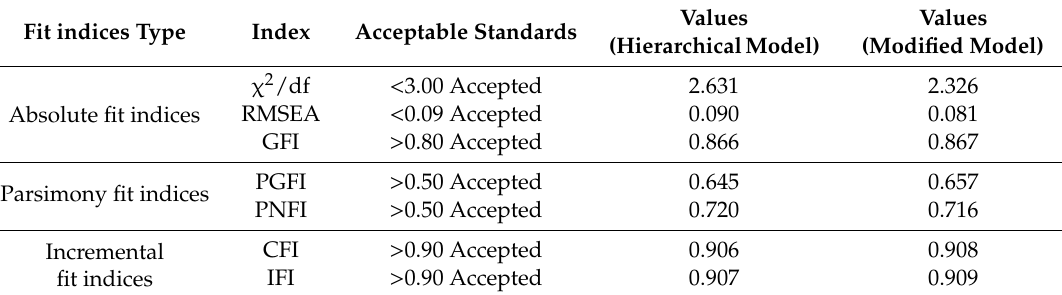
Table 11. Results of goodness-of-fit